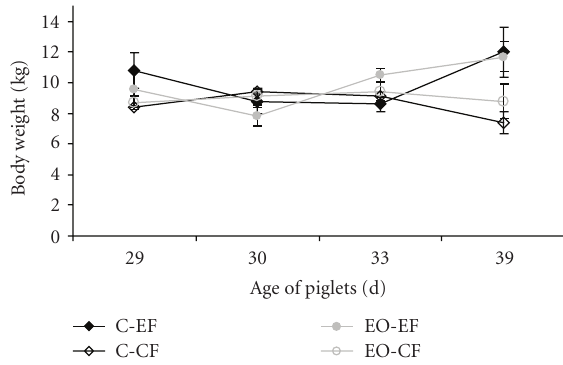
Figure 1: Body weight of piglets 1, 2, 5, and 11 days after weaning that were fed either a diet without (C) or with essential oils (EO) and reared at a commercial (CF) or experimental farm